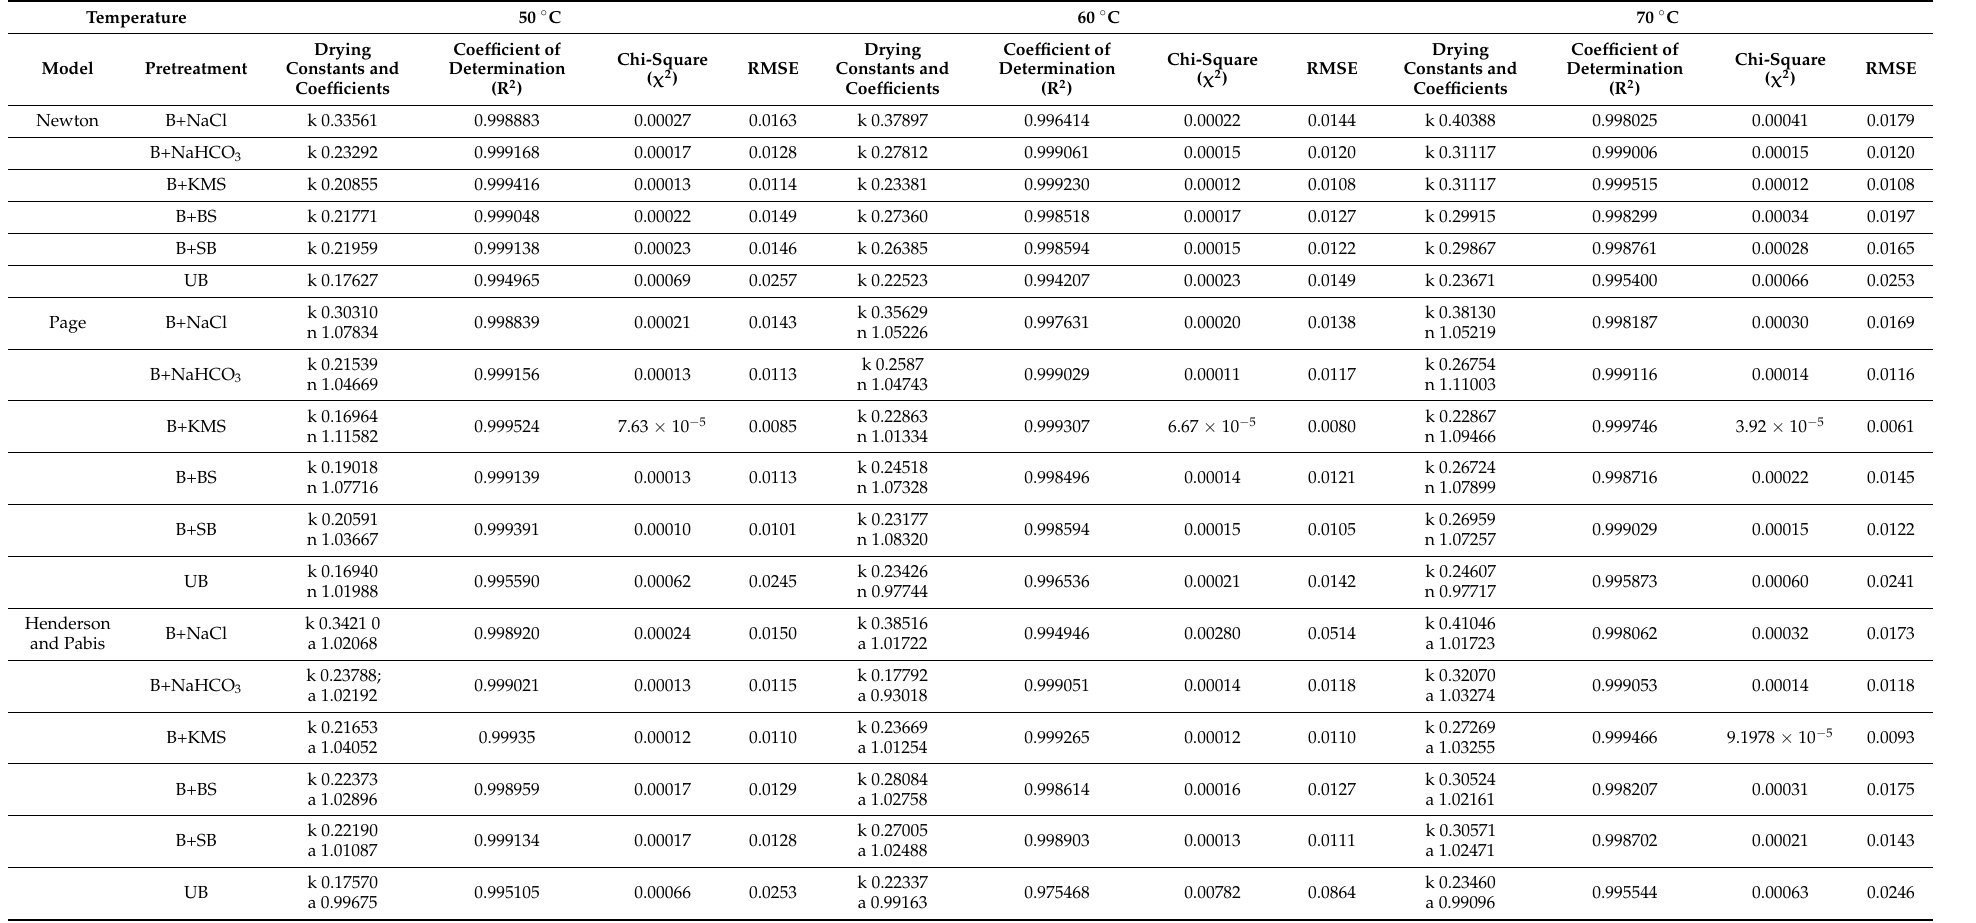
Table 2. Statistical analysis of different thin layer drying models of Moringa leaves under fluidized bed